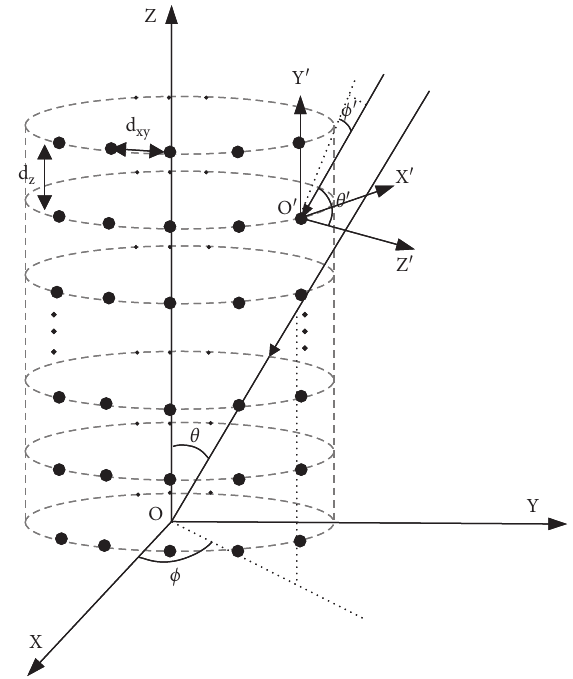
Figure 1: Conformal array coordinate